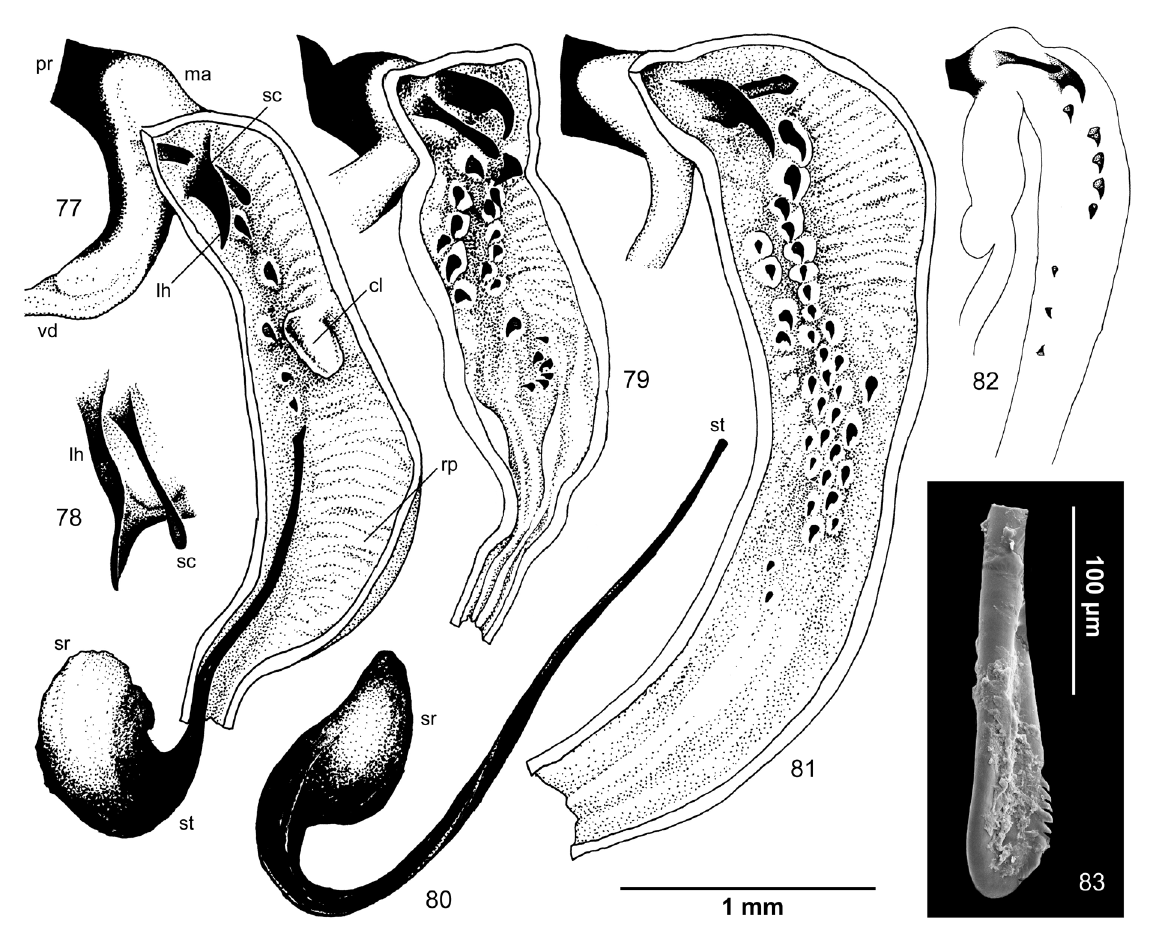
tail; sr = spermatophore reservoir; vd = vas